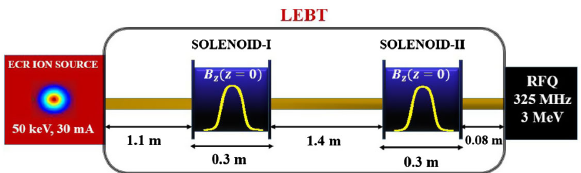
FIG. 2. Layout for the low energy beam transport channel for the MEHIPA